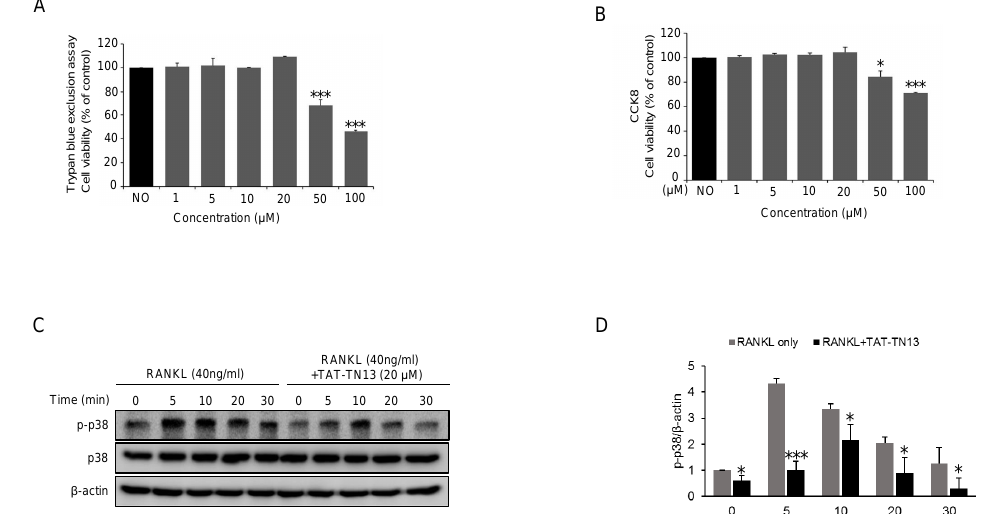
Figure 1. RANKL induces p38 MAPKs activation and TAT-TN13 inhibits it in a time-dependent manner without cytotoxic effects in vitro. Viability of TAT-TN13 treated RAW 264.7 cells was tested by a trypan blue assay ( A ) and CCK8 assays ( B ) at 24 h with various concentration. ( C ) RAW 264.7 cells were treated with or without 20 µ M TAT-TN13 for 1 h and then treated with 40 ng/mL RANKL for the indicated times. Cell lysates were analysed by Western blotting with the anti-phospho-p38 antibody, anti-p38 antibody and β -actin (control). ( D ) Statistical analysis of p-p38 levels in ( C ). These experiments were repeated three times. The results are presented as the mean ± S.D of three independent experiments (* p < 0.05 and *** p < 0.001; n.s.: not significant, ( n =